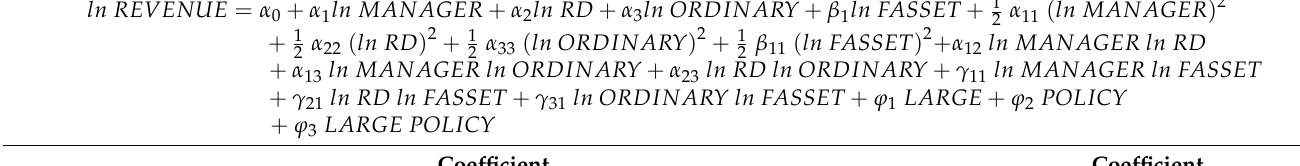
Table 5. Estimation of translog revenue function for data pooled over 2015–2020 ( t –statistics in